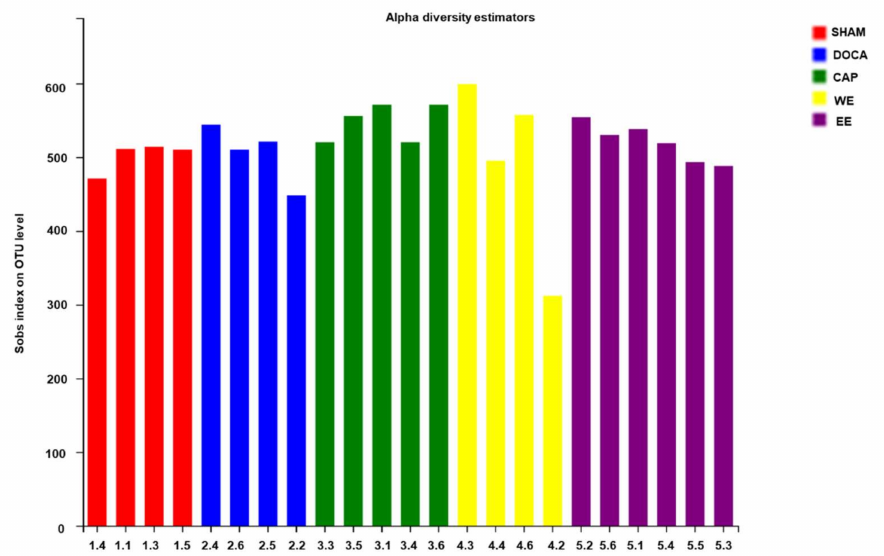
Figure A2. Effect of water extract and ethanol extract of L. rhamnosus -fermented soymilk on Alpha diversity of gut microbiota in DOCA-salt hypertensive rats at week 14.